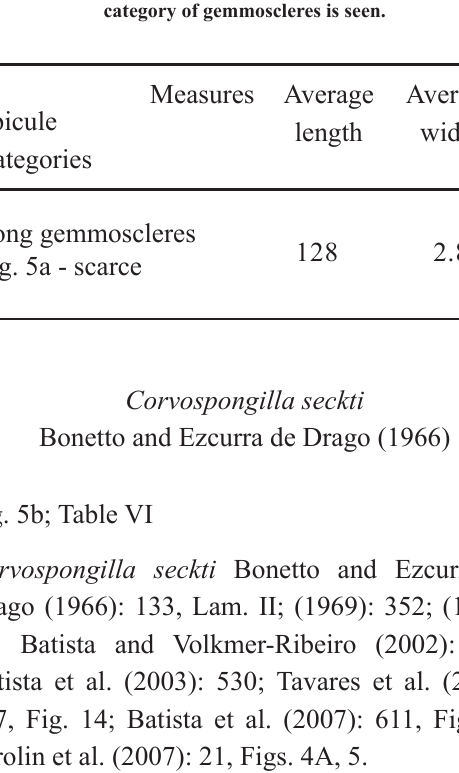
Category and measures (µm) of spicules of H. fistula detected in the three studied sections. Spicules are scarce, and only the long category of gemmoscleres is seen.